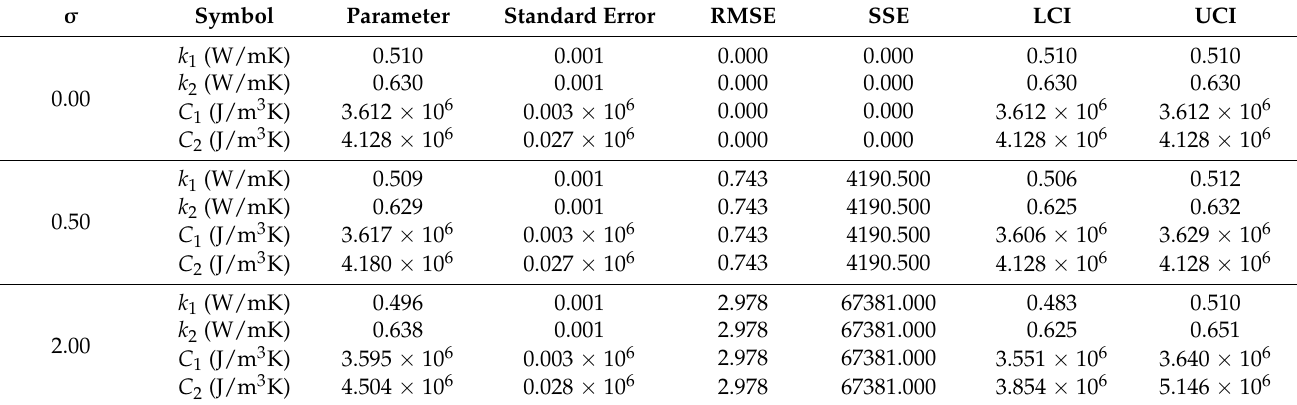
Table 1. Impact of experimental error ( σ ) on the estimation of temperature-dependent thermal pa- rameters.